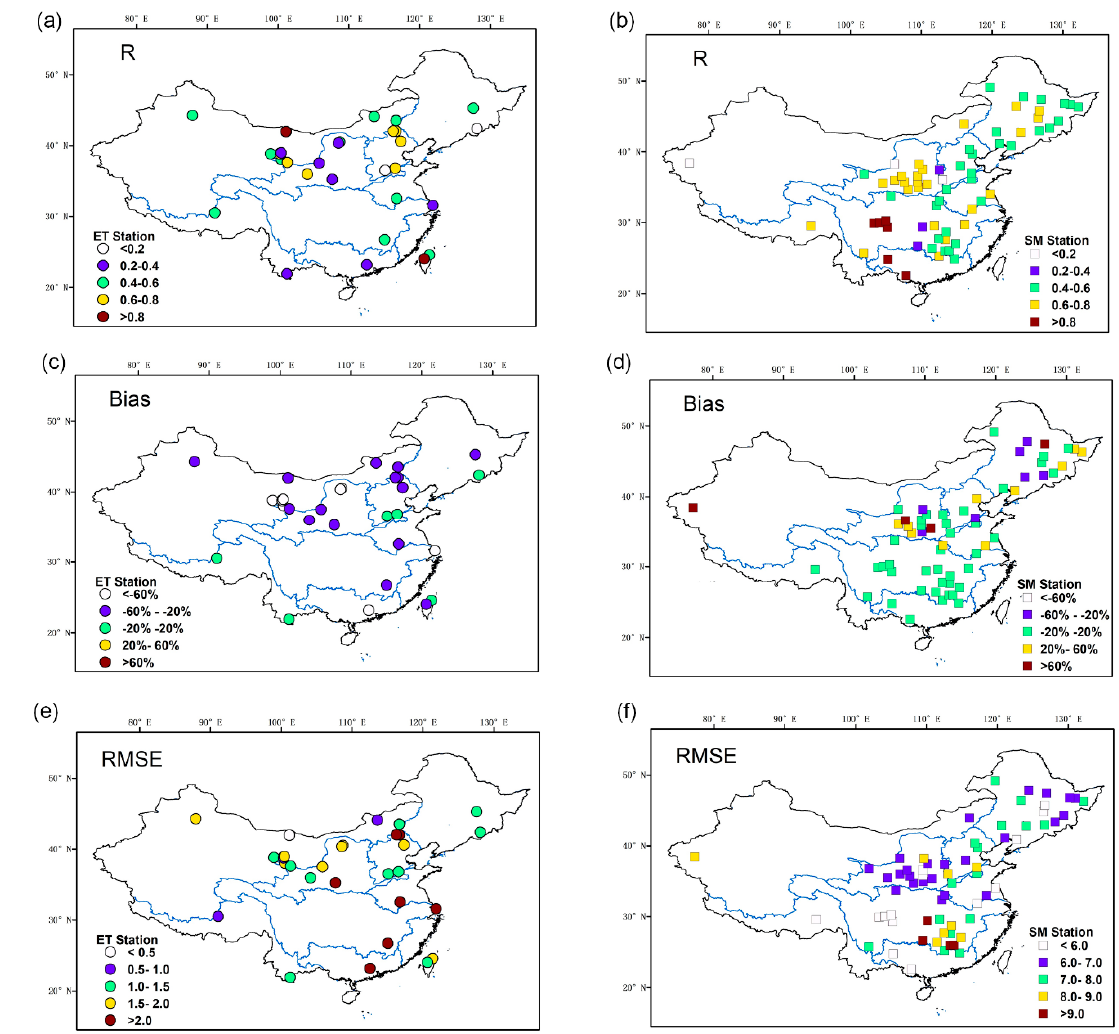
Figure 4. ET and SM evaluations with ground-based observations. The correlation coefficient (R) ( a , b ), bias ( c , d ), and RMSE (mm) ( e , f ) are